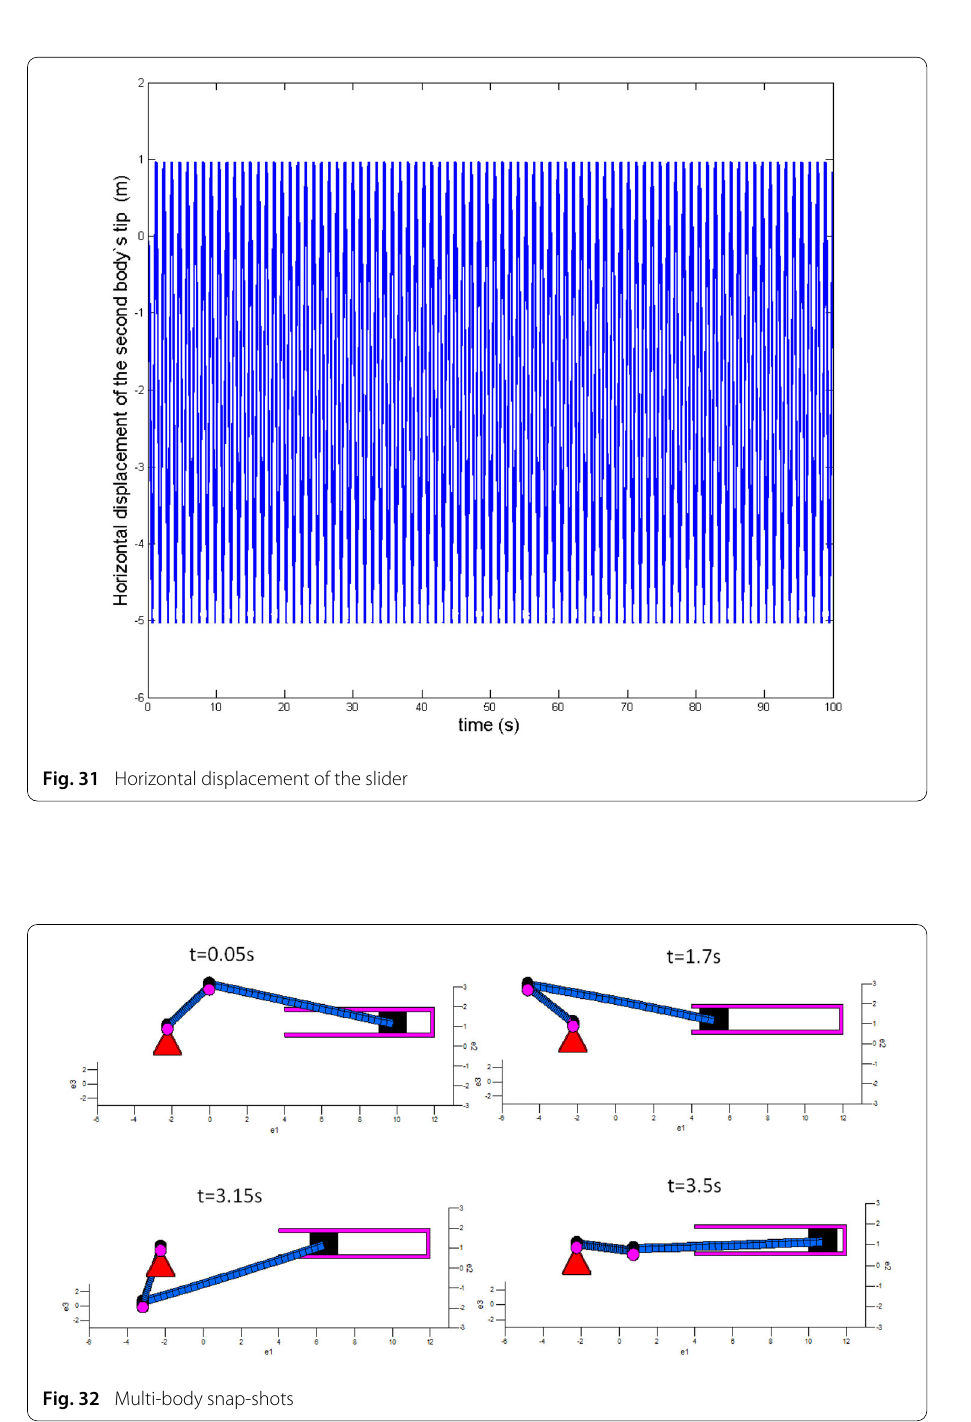
Anotherexcellentperformanceoftheformulationisshownwiththisclassicalexampleof multibody mechanism. The energy is perfectly conserved for the whole time (see Fig. 30). The displacement time history of the slider is depicted in Fig. 31, here again no sign of instability is observed. Snap-shots of the motion are presented in Fig.